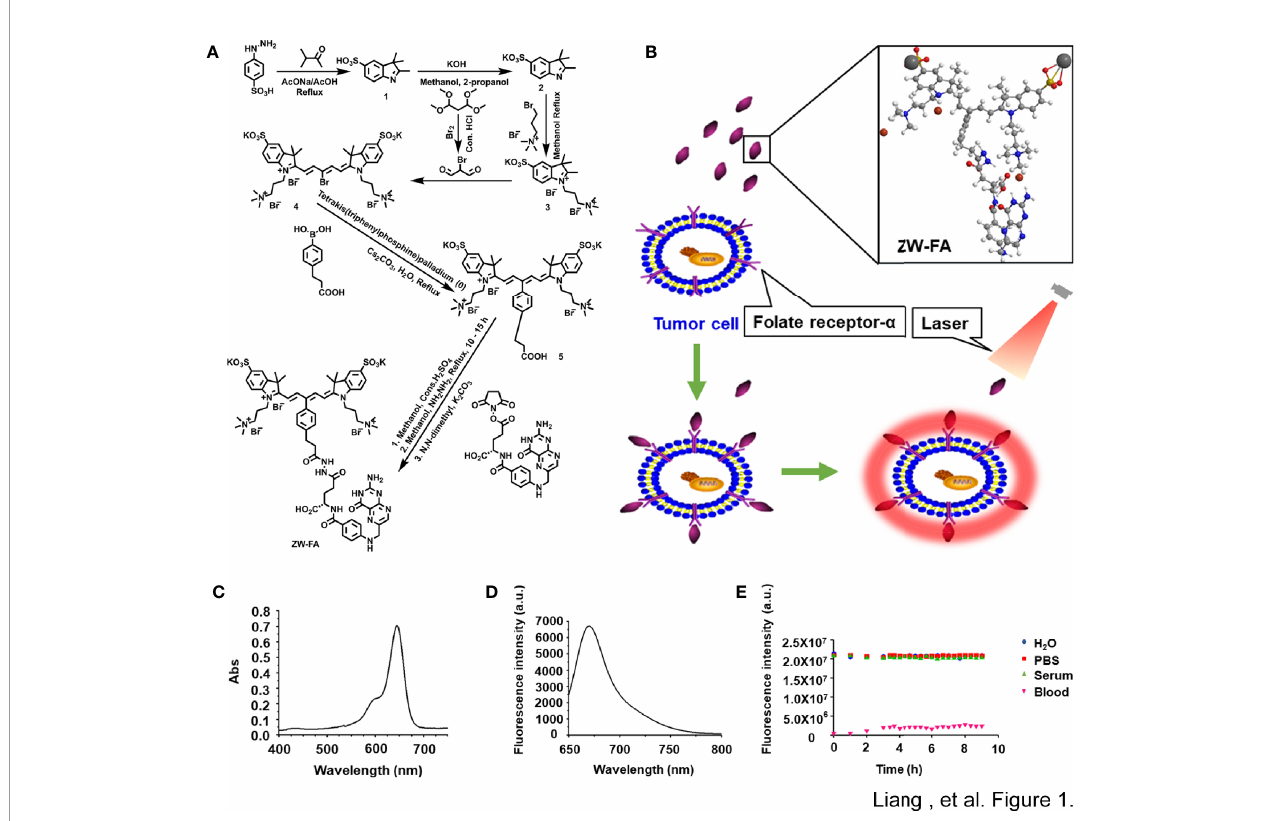
FIGURE 1 | The synthesis and Characterization of ZW-FA. (A) Synthesis steps of ZW-FA. (B) Schematic diagram of the working principle for detecting endometrial cells and the ball-and-stick model of ZW-FA. ZW-FA bound to the FR- a of cell, and the ZW-FA-cell complex could emit near-infrared fl uorescence with 633nm laser. (C) Ultraviolet spectra of ZW-FA (7.14 ug/ml). (D) Fluorescence spectra of ZW-FA (7.14 ug/ml) at 668 nm. l ex =633 nm, slit width: d em =10.0 nm, d ex =2.5 nm. (E) In a variety of biological media at 37°C under continuous laser exposure at 650-850